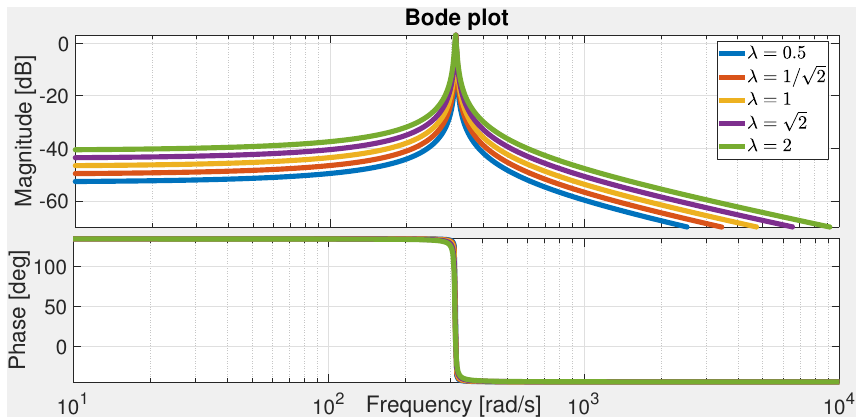
Figure 1. Frequency response of the proposed enhanced reduced-order generalized integrator for various closed-loop poles. Legends indicate the value of λ with λ = λ 1 = λ 2